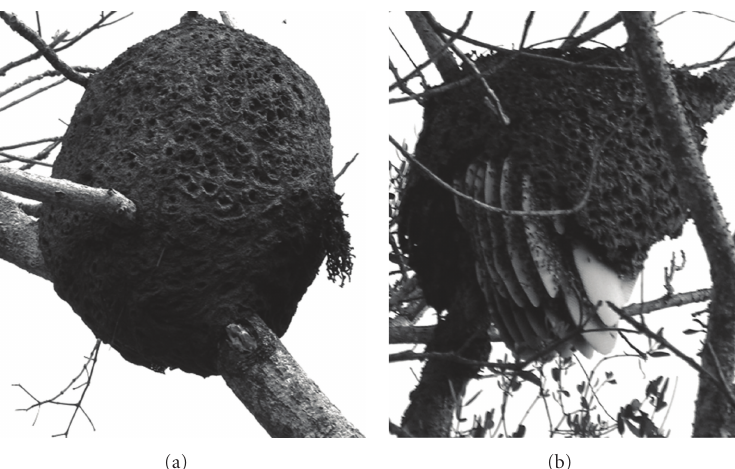
Figure 1: (a) Active nest of Trigona corvina , Cerro Campana, Panama. (b) Active nest of Africanized Apis mellifera established in the scutellum of Trigona corvina near Summit Gardens, Panama city, Panama.